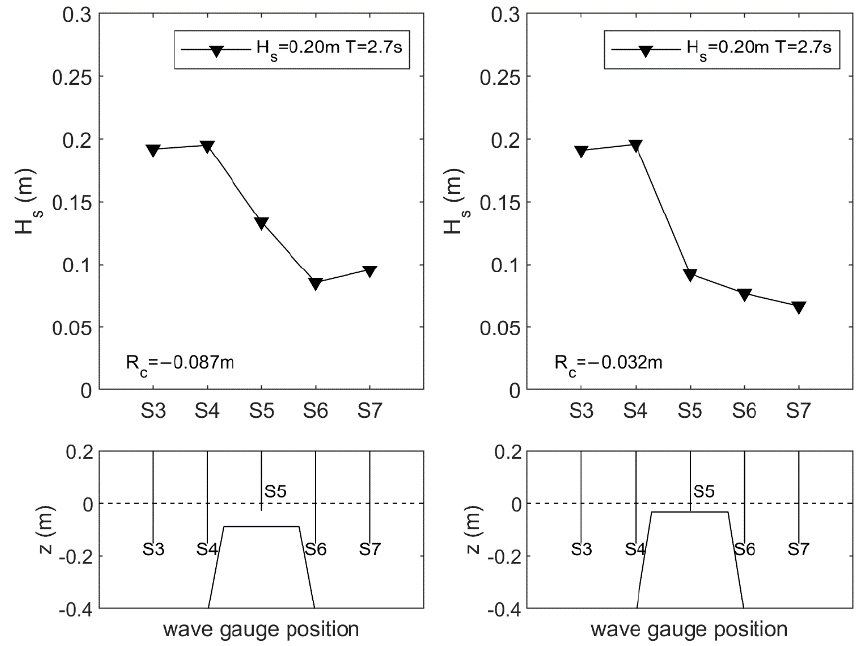
Figure 12. Wave height evolution before, over and behind a submerged breakwater with R c = − 0.087 m ( left panel ) and R c = − 0.032 m ( right panel ) for random waves with a significant wave height Hs = 0.20 m the peak period T p = 2.7s.